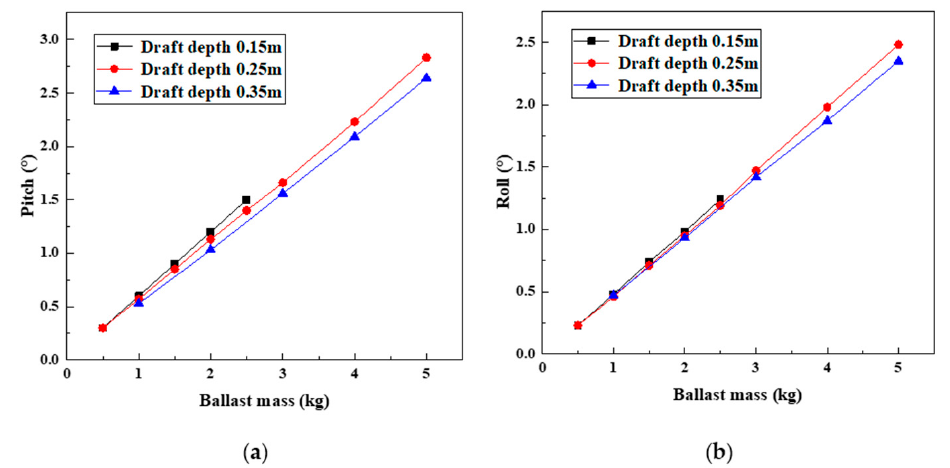
Figure 13. Pitch and roll for the eccentric load. ( a ) Pitch. ( b ) Roll.